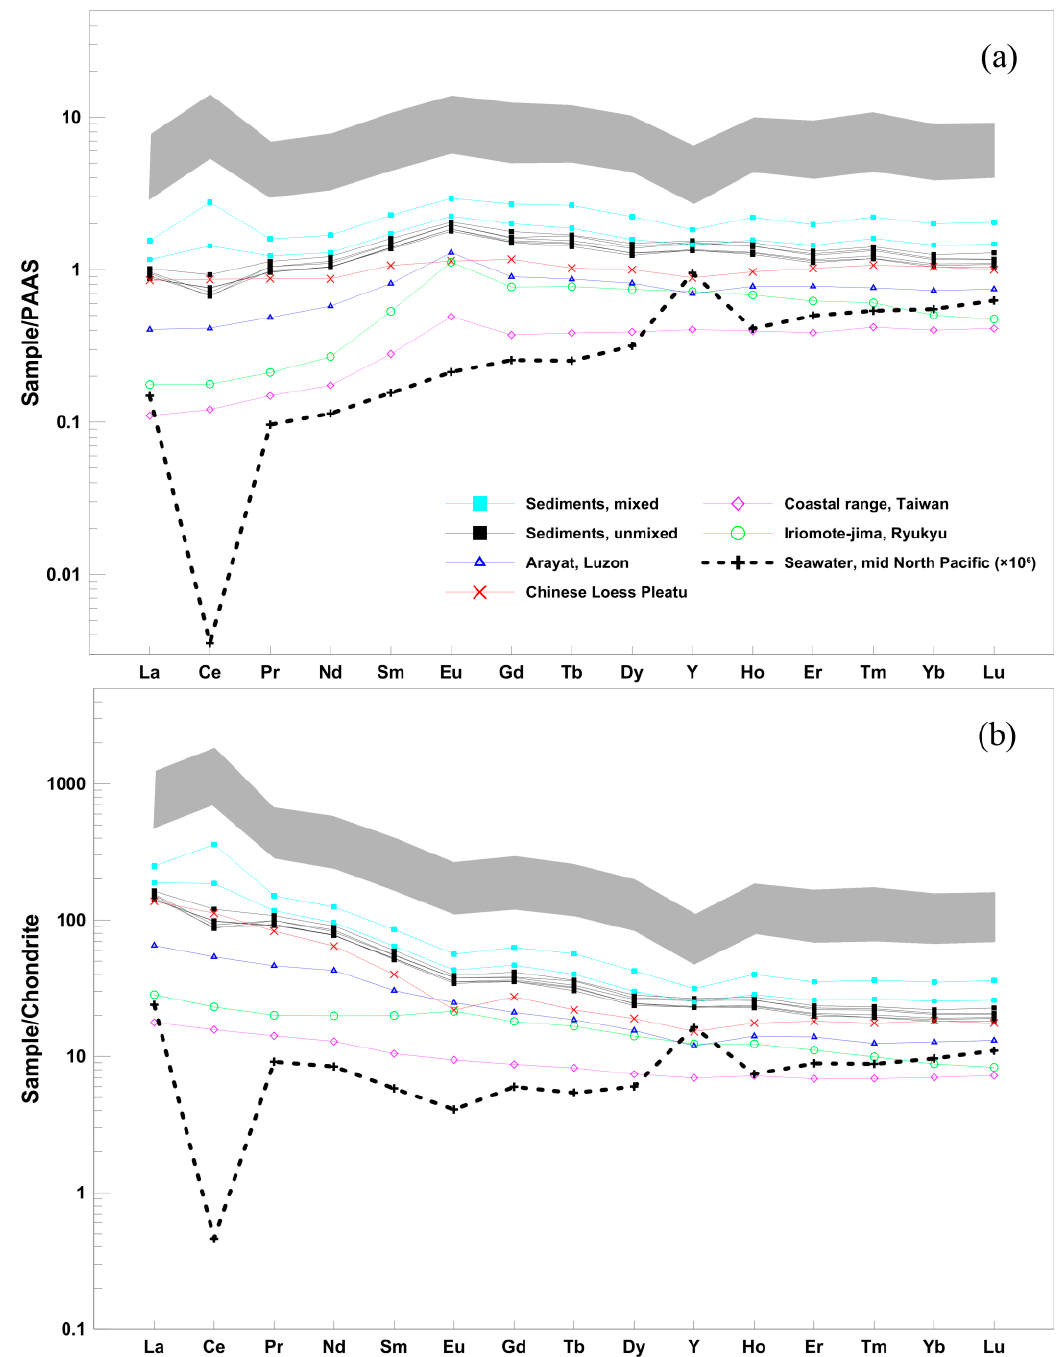
Figure 4. ( a ) Post-Archean Australian shale (PAAS)-normalized rare earth element plus Y (REY) patterns. ( b ) Chondrite-normalized REY patterns. Data on Chinese loess and Pacific seawater at a depth of ~4000 m, and the volcanic rocks from the Mount Arayat, Iriomote-jima Island, and the Coastal Range of Taiwan, are from Ding et al. (2001) [33], Zhang and Nozaki (1996) [38], Bau and Knittel (1993) [34], Shinjo (1999) [35], and Lai et al. (2008; 2017) [36,37], respectively. REY patterns of crusts and nodules from the Gagua Ridge (ref. Chen et al. (2018) [3]) are indicated by the gray shaded area.